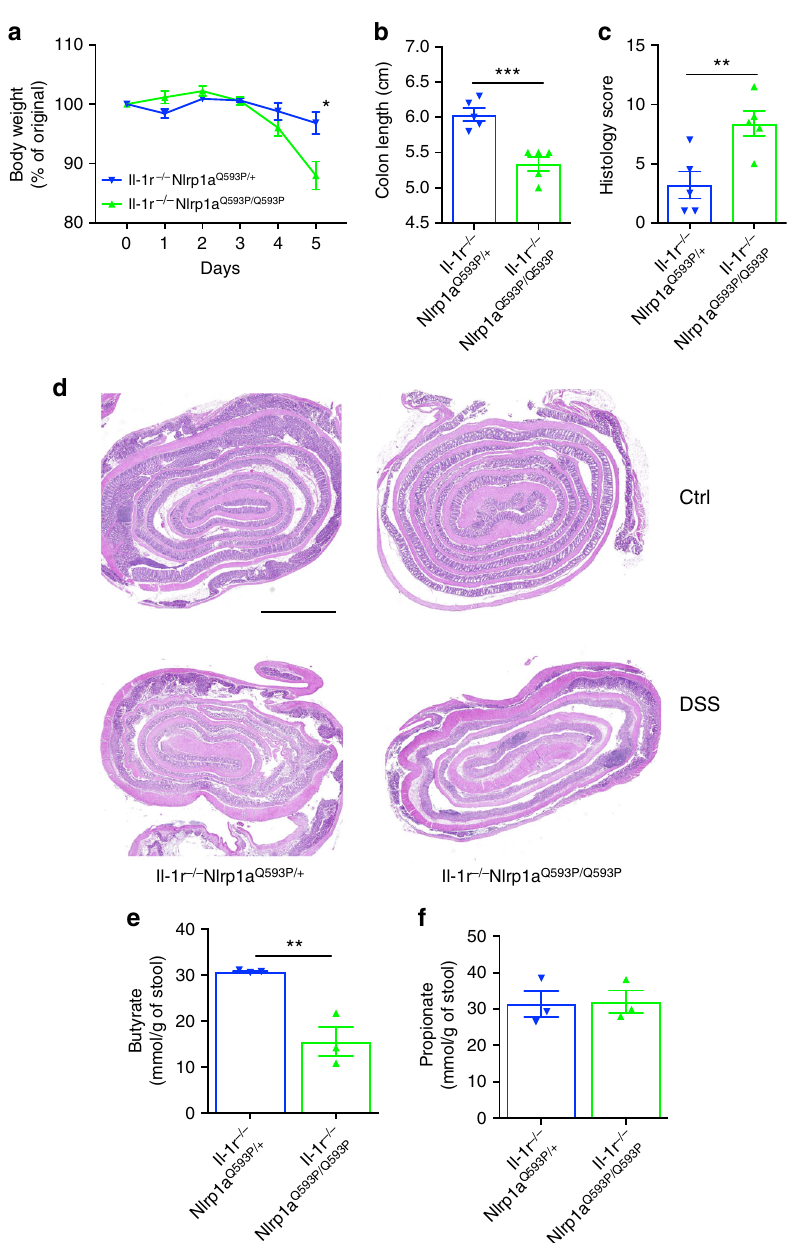
Fig. 4 Hyper-activation of Nlrp1 exacerbates DSS-induced colitis independent of IL-1R signaling. Il-1r − / − Nlrp1a Q593P/ + and Il-1r − / − Nlrp1a Q593P/Q593P mice were given 3% (w/v) DSS for 6 days. a The percentage weight loss, b colon length and c histology score for epithelial damage and in fl ammatory cell in fi ltrate of H&E-stained sections of the colon were measured for disease severity. d Representative H&E-stained sections of the distal colon from Il-1r − / − Nlrp1a Q593P/ + and Il-1r − / − Nlrp1a Q593P/Q593P mice, scale bar = 2mm. Short chain fatty acid analysis was performed on fecal samples collected from WT and Nlrp1 − / − mice before (UT) and after vancomycin treatment. The concentrations of e butyrate and f propionate were measured by gas chromatography mass